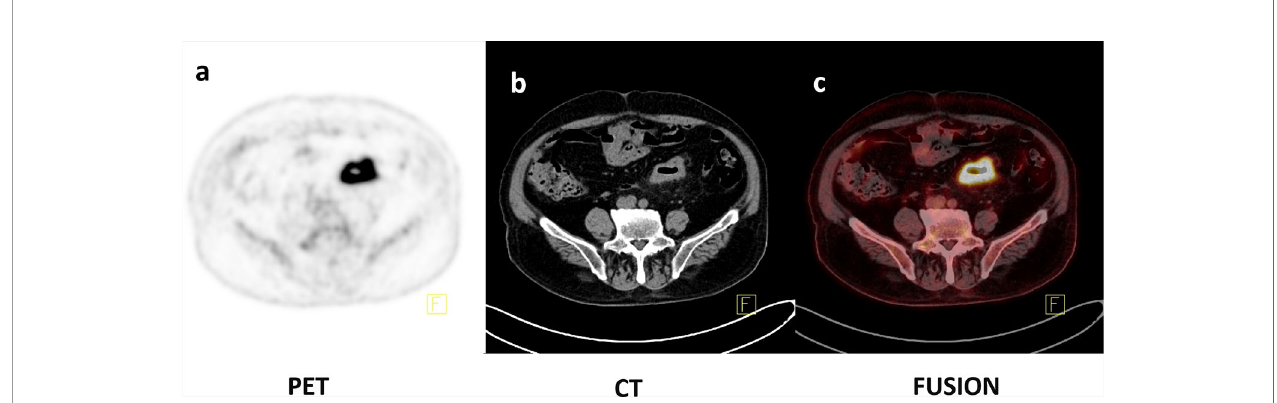
FIGURE 3 | Axial PET, CT, and fusion images of an 86-year-old female with histopathologically proven CRC with MSI (A – C) . 18 F-FDG PET/CT images showed that intense uptake in the sigmoid colon (SUV max = 22.59, SUV peak = 15.91, SUV mean50% = 14.22, MTV 50% = 13.23 ml, TLG 50% = 188.13).